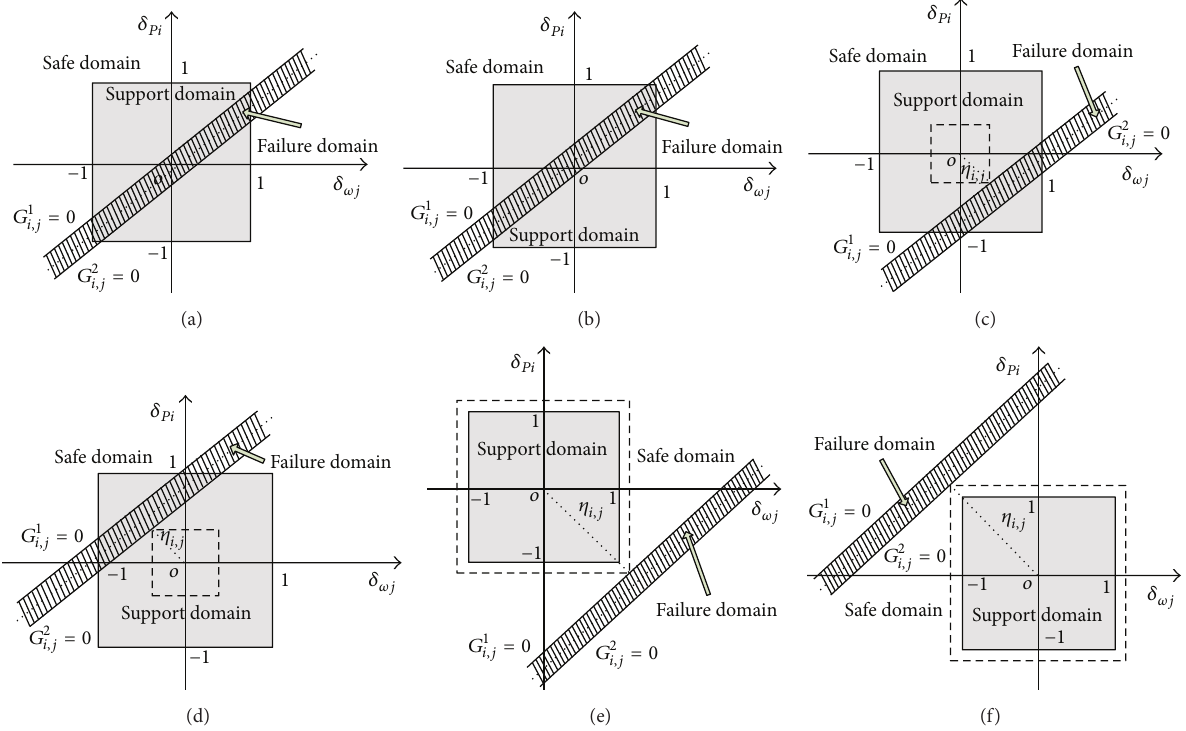
Figure 4: The failure modes of resonance corresponding to different relationships between 𝑃 𝑖 and 𝜔 𝑗 . (a) 0 ≤ 𝑃 𝑖𝑐 − 𝜔 𝑗𝑐 ≤ 𝛾 , overlapping. (b) −𝛾 ≤ 𝑃 𝑖𝑐 − 𝜔 𝑗𝑐 ≤ 0 , overlapping. (c) 𝑃 𝑖𝑐 > 𝜔 𝑗𝑐 , overlapping. (d) 𝑃 𝑖𝑐 < 𝜔 𝑗𝑐 , overlapping. (e) 𝑃 𝑖𝑐 > 𝜔 𝑗𝑐 , not overlapping. (f) 𝑃 𝑖𝑐 < 𝜔 𝑗𝑐 , not